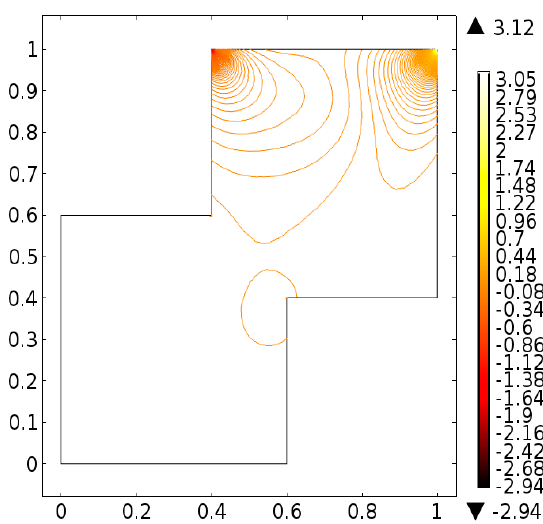
Figure 16. Pressure distribution at Re = 100 for case-I.